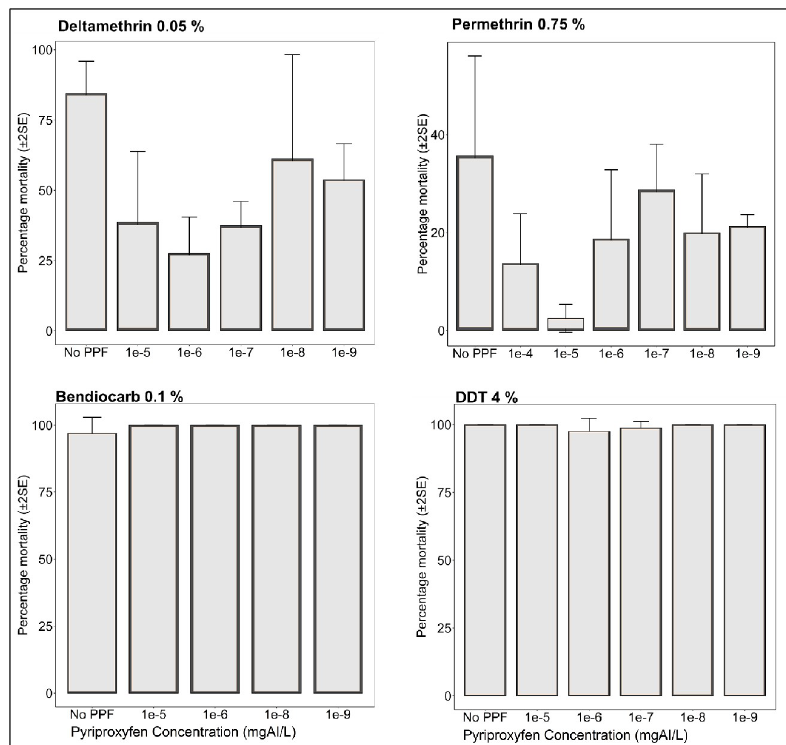
Fig 3. Percentage mortality (24-hour) of resistant An . arabiensis colony mosquitoes reared through different doses of PPF (mg of active ingredient per litre, i.e. mgAI/L) and exposed to commonly used insecticides using standard WHO susceptibility testing guidelines. Bars labelled “No PPF” represent percentage mortality of mosquitoes from the same colony, which were not treated with PPF but were exposed to the same insecticide at standard WHO-recommended